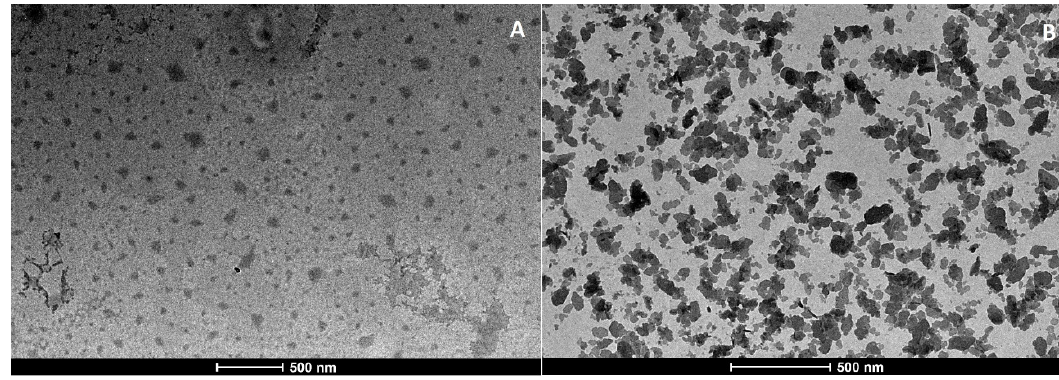
Figure 3. TEM images of SLN-G ( A ) and SLN-Gb ( B ).